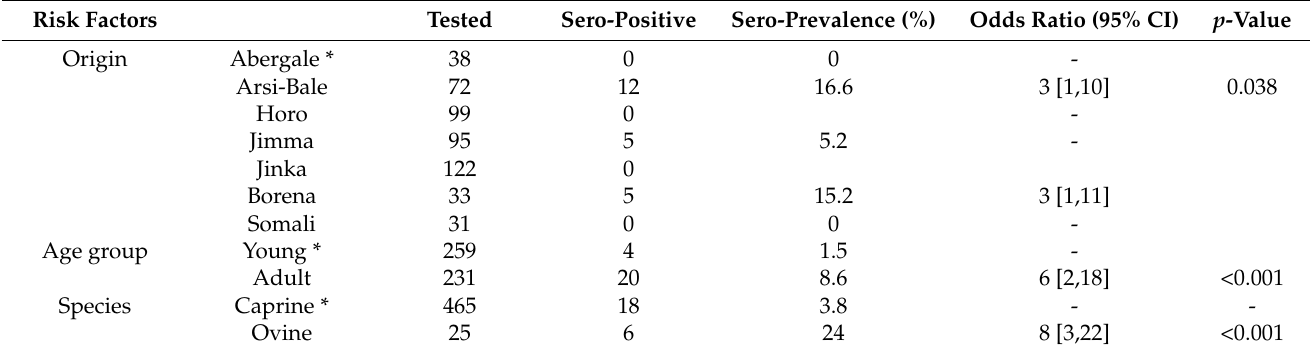
Table 5. Factors associated with FMD sero-positivity using multivariable logistic regression analysis in domestic small ruminants ( N =